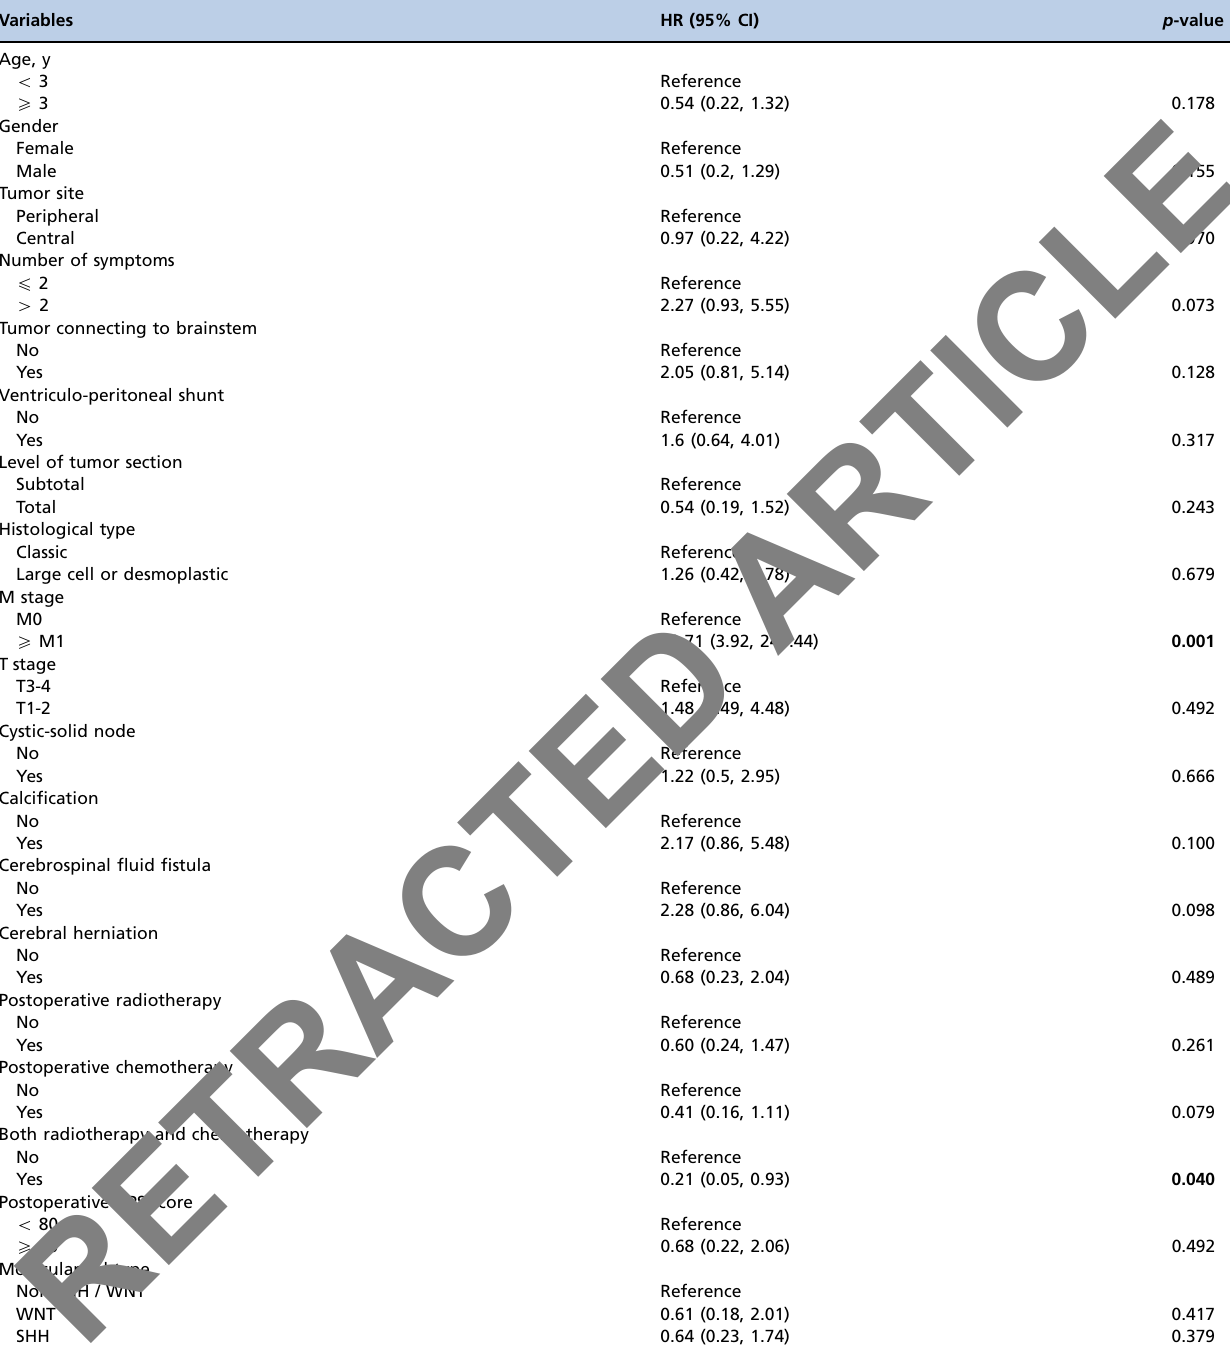
Table 4 - Univariate Cox proportional hazard model of factors associated with medulloblastoma recurrence. Variables